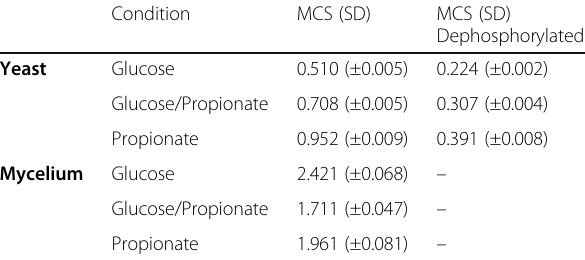
Table 2 Methylcitrate synthase activity in cell extracts of yeast and mycelial forms of P. lutzii incubated in glucose, glucose with propionate or only